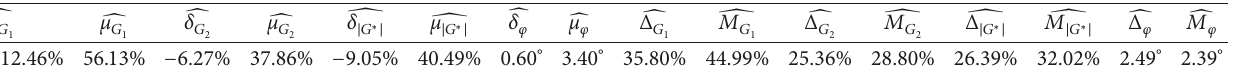
) and absolute error for φ ( Δ i